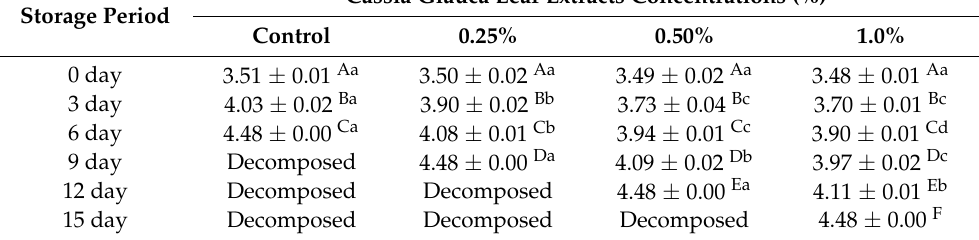
Table 8. Pattern of the Enterobacteriaceae count (log10 cfu/g) in minced beef treated with ethano- lic Cassia glauca leaf extracts (0.25%, 0.5%, 1%) during the cold storage period at 3 ± 1 ◦ C (mean ± standard deviation “SD”).